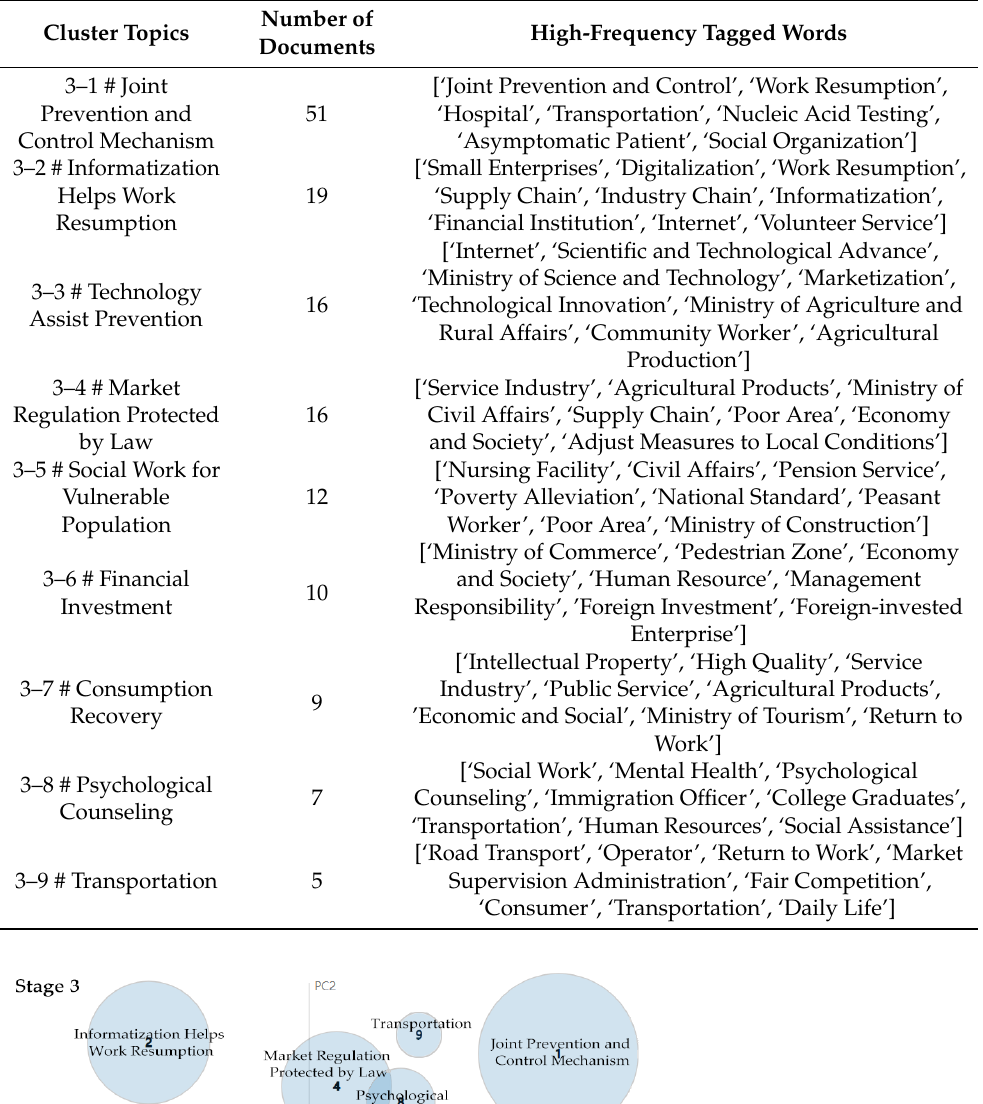
Table 3. Topic contents in Stage 3.